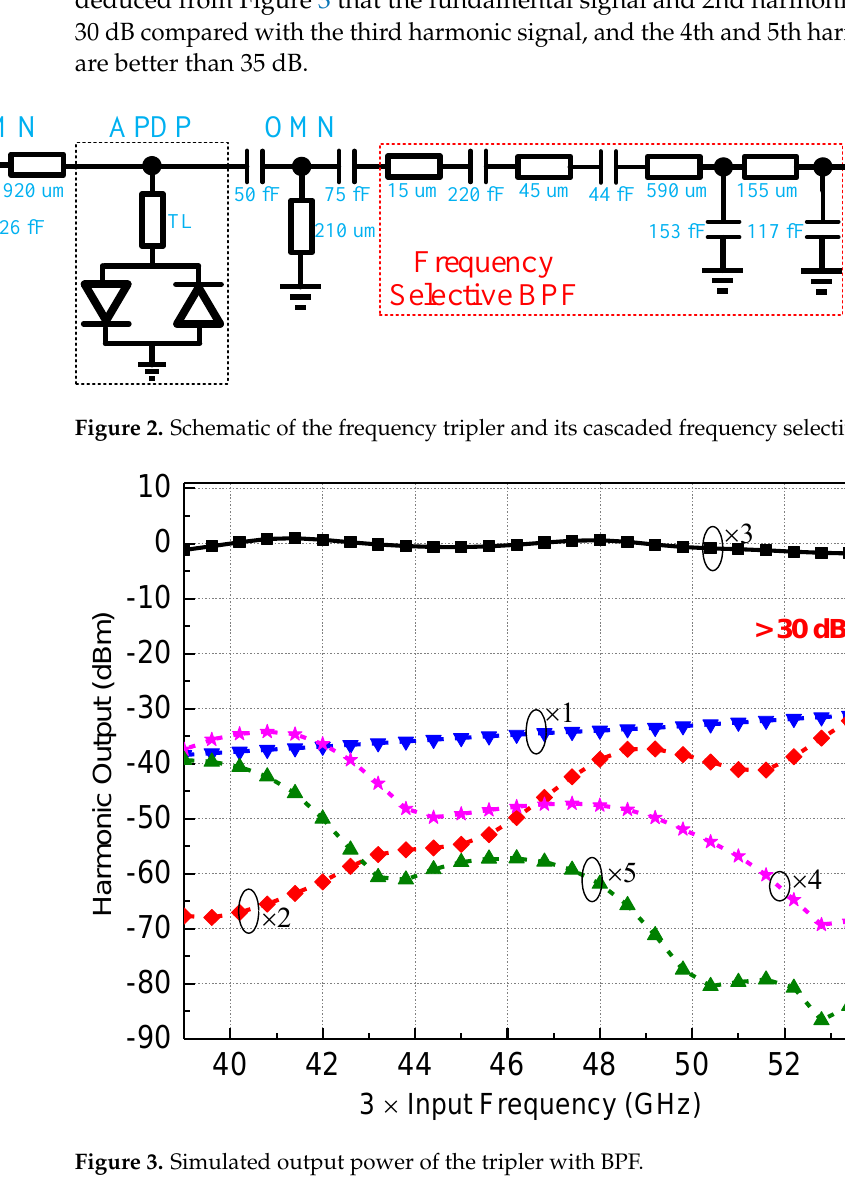
Figure 2. Schematic of the frequency tripler and its cascaded frequency selective BPF.